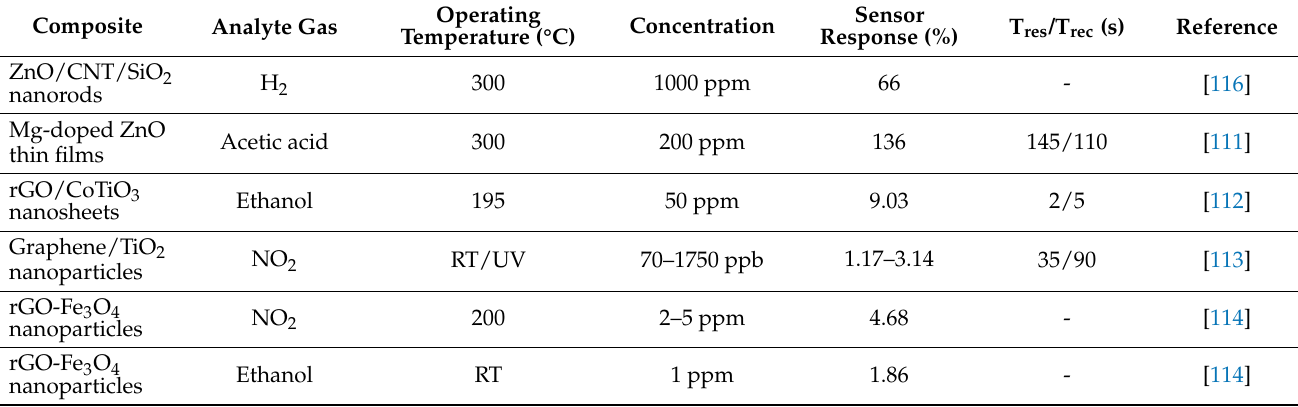
Table 4. Previous studies of graphene-based materials synthesised using the sol-gel